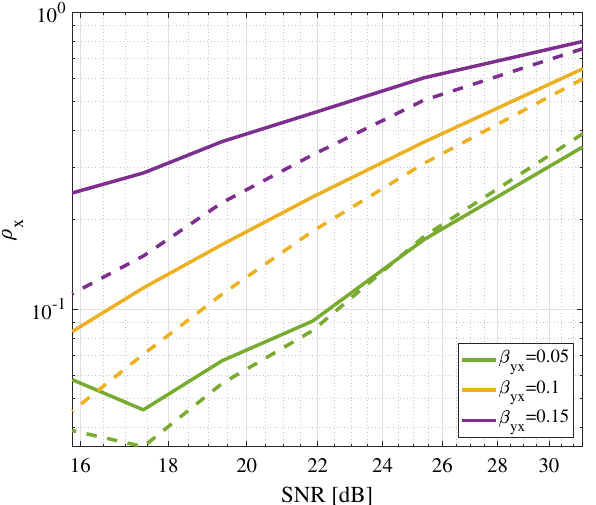
Figure 8. Cross-map skill ρ x as a function of noise in the effect variable σ y and level of coupling β yx in the coupled logistic map problem. The proposed combination of CCM and IGCI (solid lines) outperform the standard CCM (dashed lines), especially noticeable in high levels of noise and coupling.